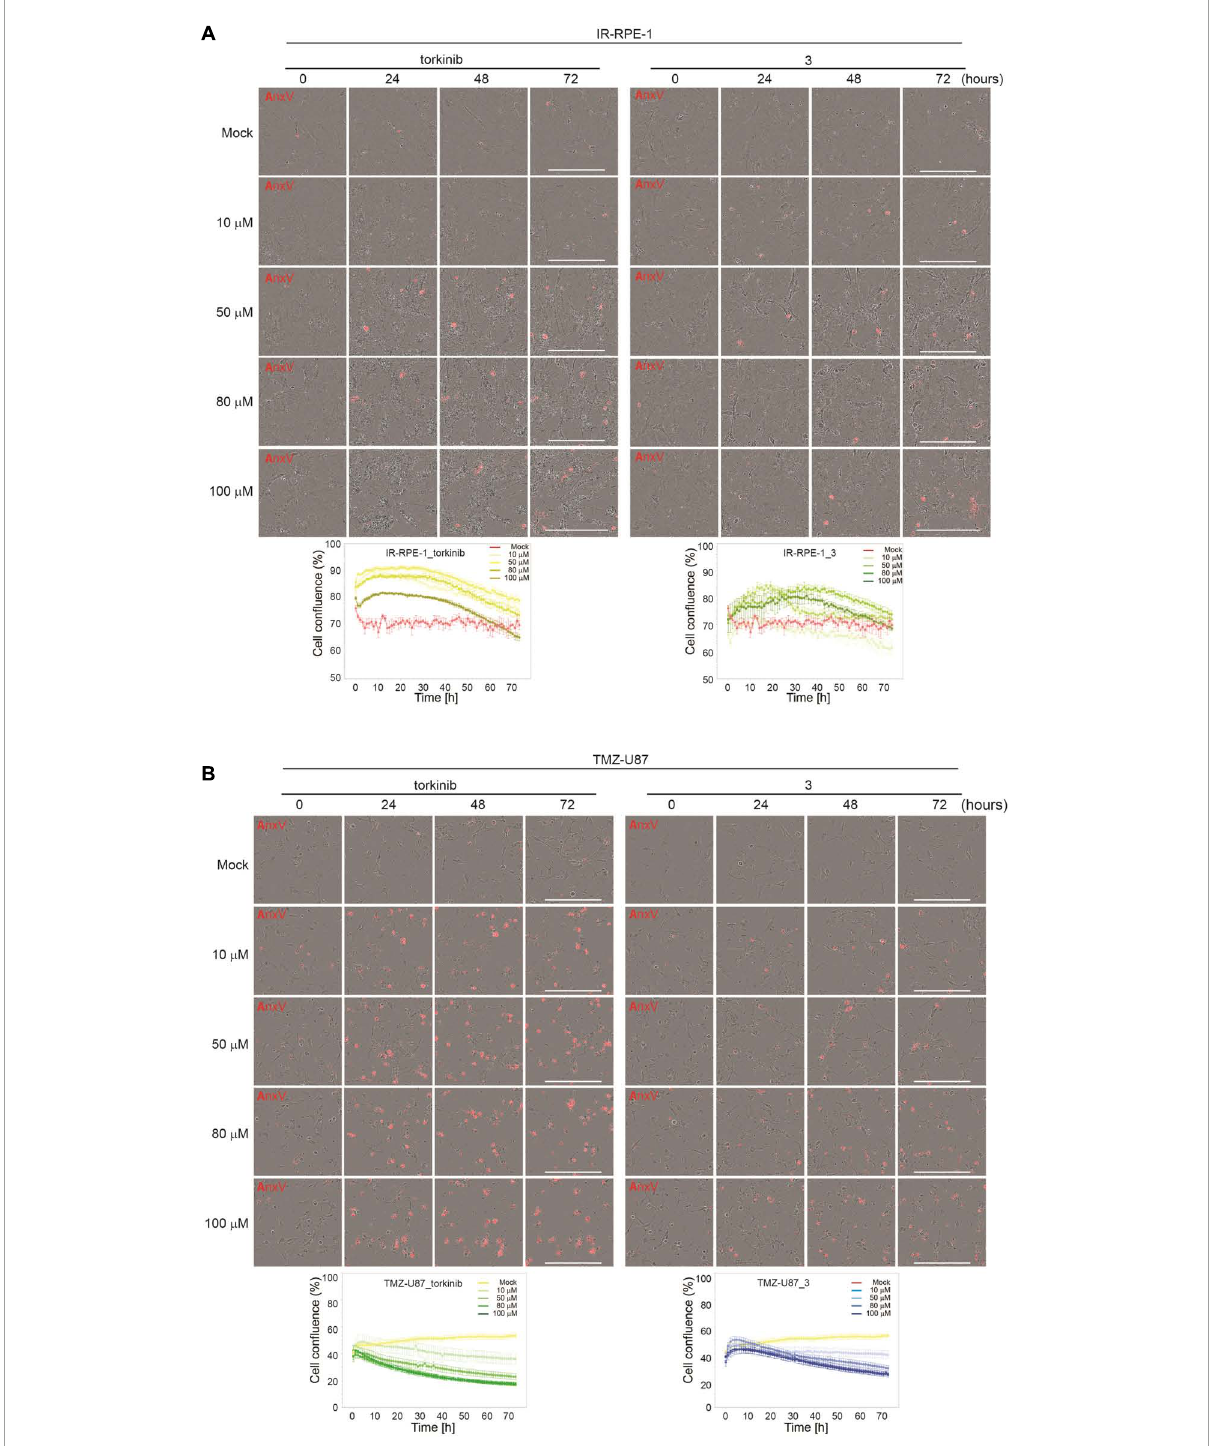
FIGURE7 Time-lapse microscopy of torkinib and compound 3 using Incucyte SX1 platform. γ -irradiated RPE-1 (A) and TMZ-induced U87 (B) senescent cells were exposed to torkinib and compound 3 in a concentration range of 0–100 µ M for 72 h. Images were acquired every 60 min. Note that the first image was acquired 30 min (corresponding to 0 h in graph plots) after adding compounds. The graphs plot changes in cell confluence during the treatment. Average cell confluence and standard error from four images are shown. End-point images (72 h) are presented. Red color is annexin V staining. Bar, 400 µ